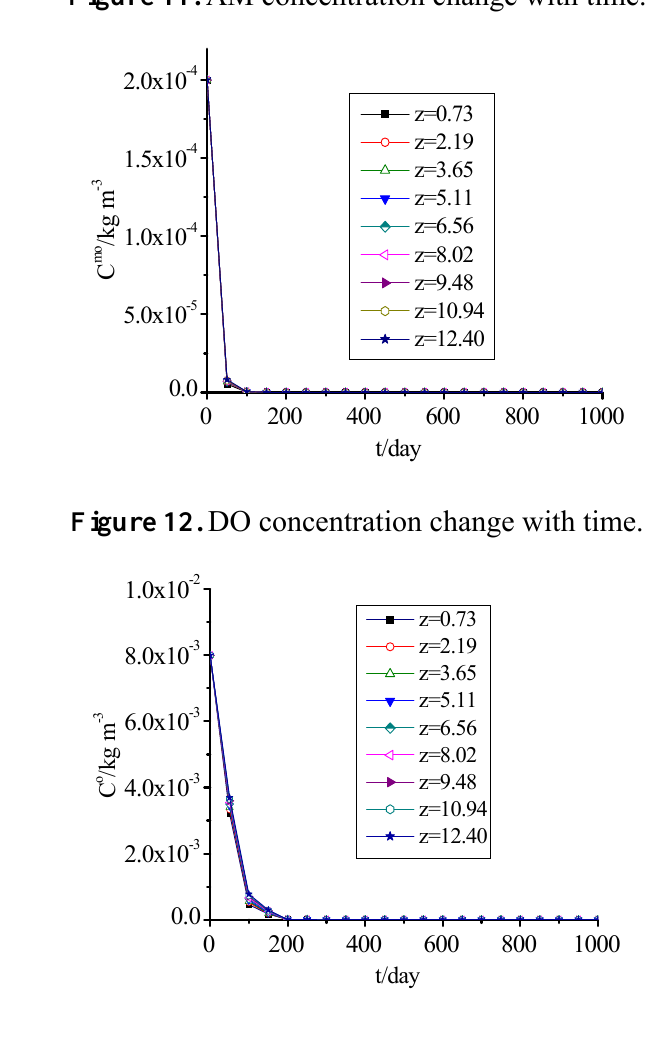
Figure 11. AM concentration change with time.